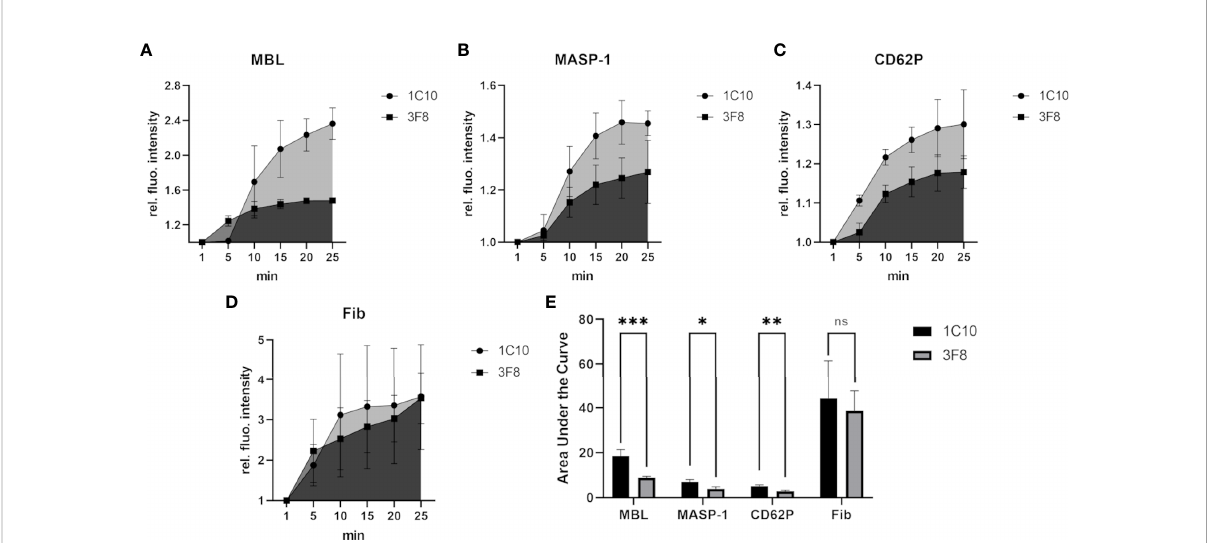
FIGURE 6 Effects of inhibiting MBL-binding in the bleeding model. To investigate the effects of the MBL inhibitory antibody 3F8, the signal intensity relative to the fi rst time point was monitored for MBL (A) , MASP-1 (B) , activated platelets (CD62P) (C) and fi brin (D) . The area under the curve was calculated using GraphPad Prism (E) . Experiments using the inhibitory 3F8 antibody showed a reduced increase of the MBL, MASP-1 and CD62P signal in comparison to the non-inhibitory control antibody 1C10, but no clear difference in fi brin signals was detected. Each experiment was performed three times, data are shown as mean with SD, and p-values for differences between groups were determined with a t-test (ns not signi fi cant, * p ≤ 0.05, ** p ≤ 0.01, *** p ≤